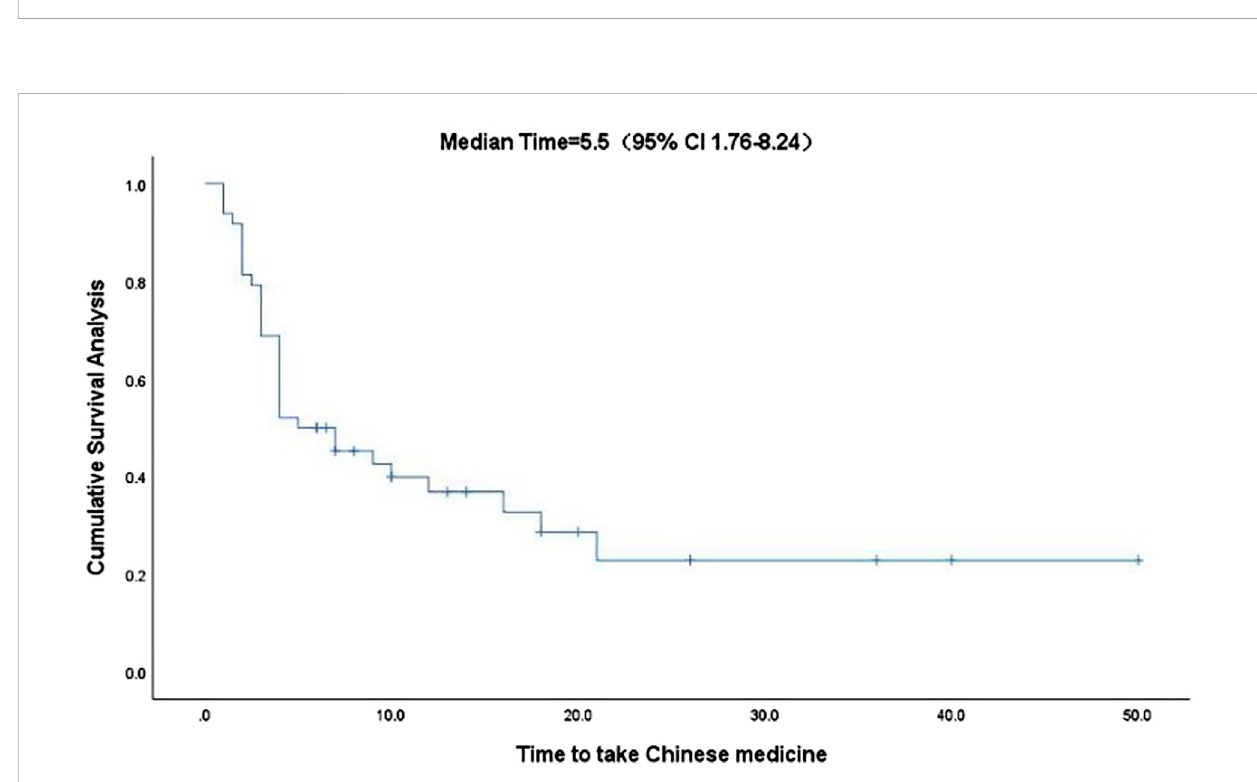
Kaplan-Meier plot showing the TTCM in patients with advanced colorectal cancer. CI, con fi dence interval; TTCM, total duration of traditional Chinese medicine